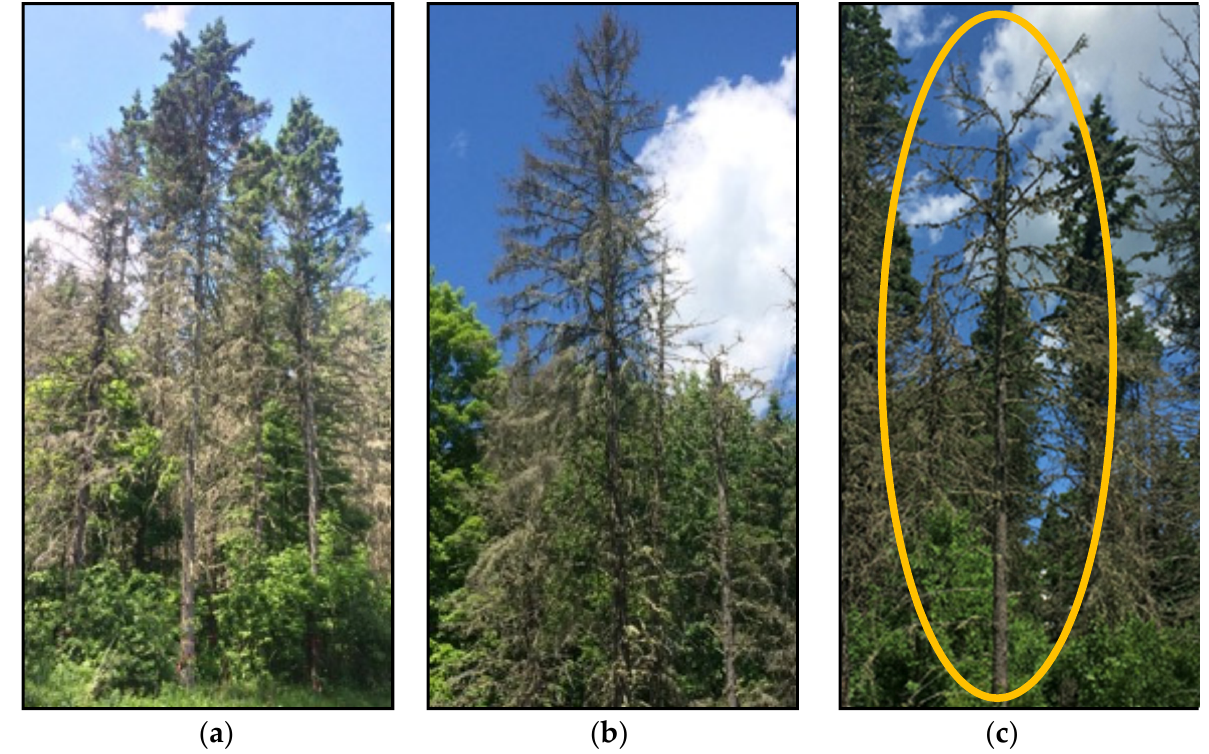
Figure 1. White spruce trees representing visual categories 1 ─ ( a ) live trees with visible green foli- age), 2 ─ ( b ) dead-standing trees with no visible green foliage, recently dead), and 3 ─ ( c ) dead-stand- ing trees with poorest visual appearance, obvious signs of severe decay.